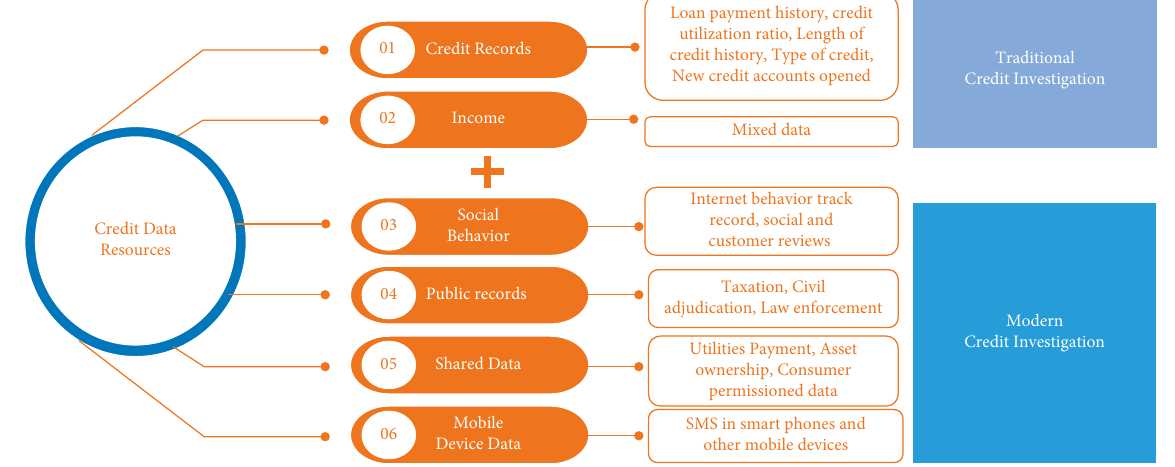
Figure 1: Credit data resources in traditional and modern credit